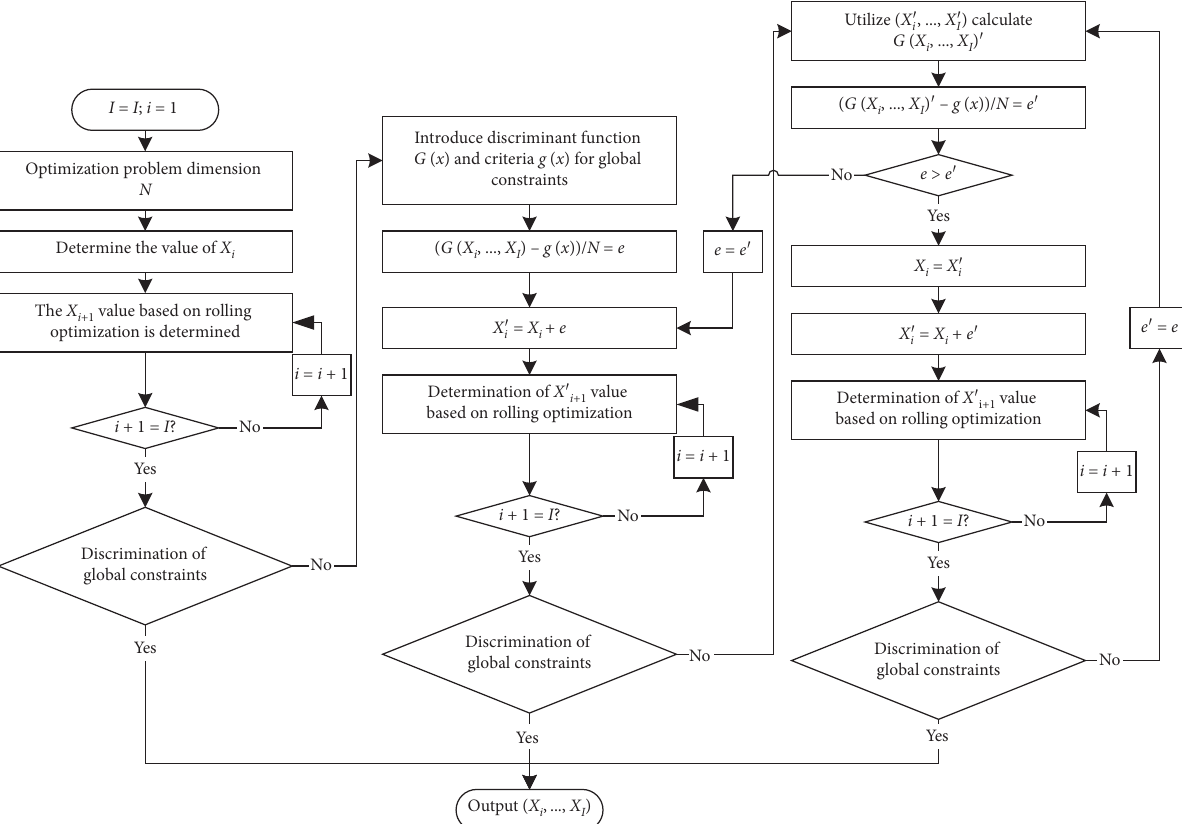
Figure 9: Flowchart of continuous rolling optimization